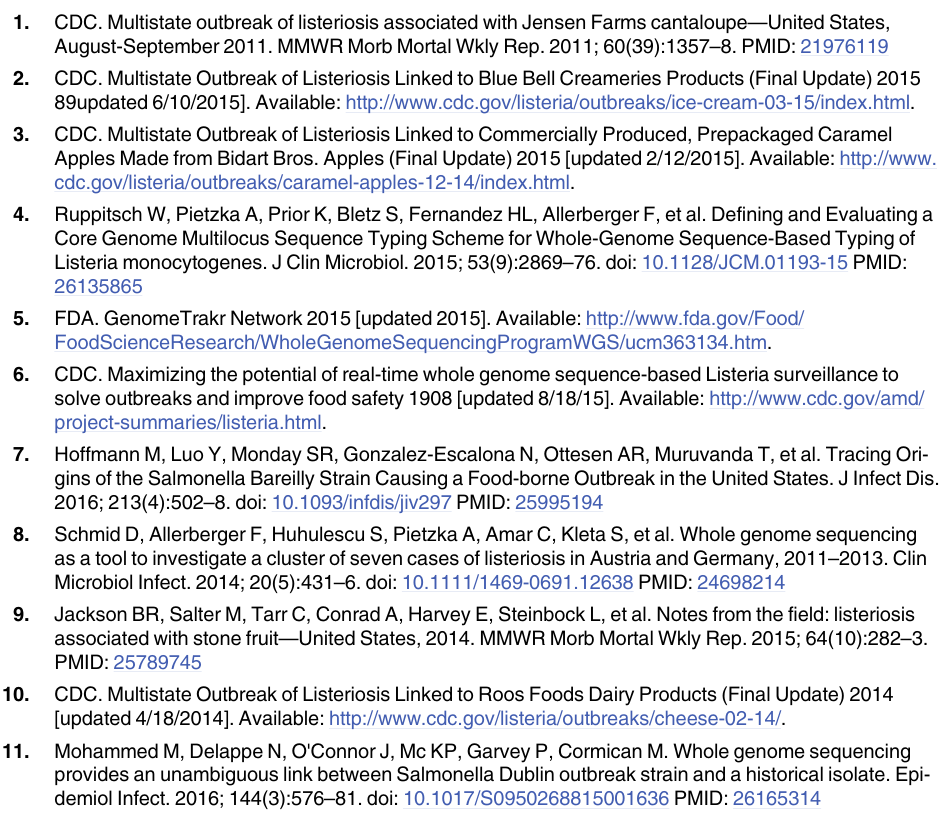
S3 Table. CFSAN Pipeline identified SNPs for Cluster 3. This table lists the SNPs found in the cluster 3 strains relative to LS642 that occurred that were found more frequently in one of the two strain subset. A period (.) indicates the nucleotide was unaltered in the test strain rela- tive to LS642 while a dash (-) indicates a gap. Each SNP was assigned as SF specific, SF biased or apple biased as noted by the position of the plus